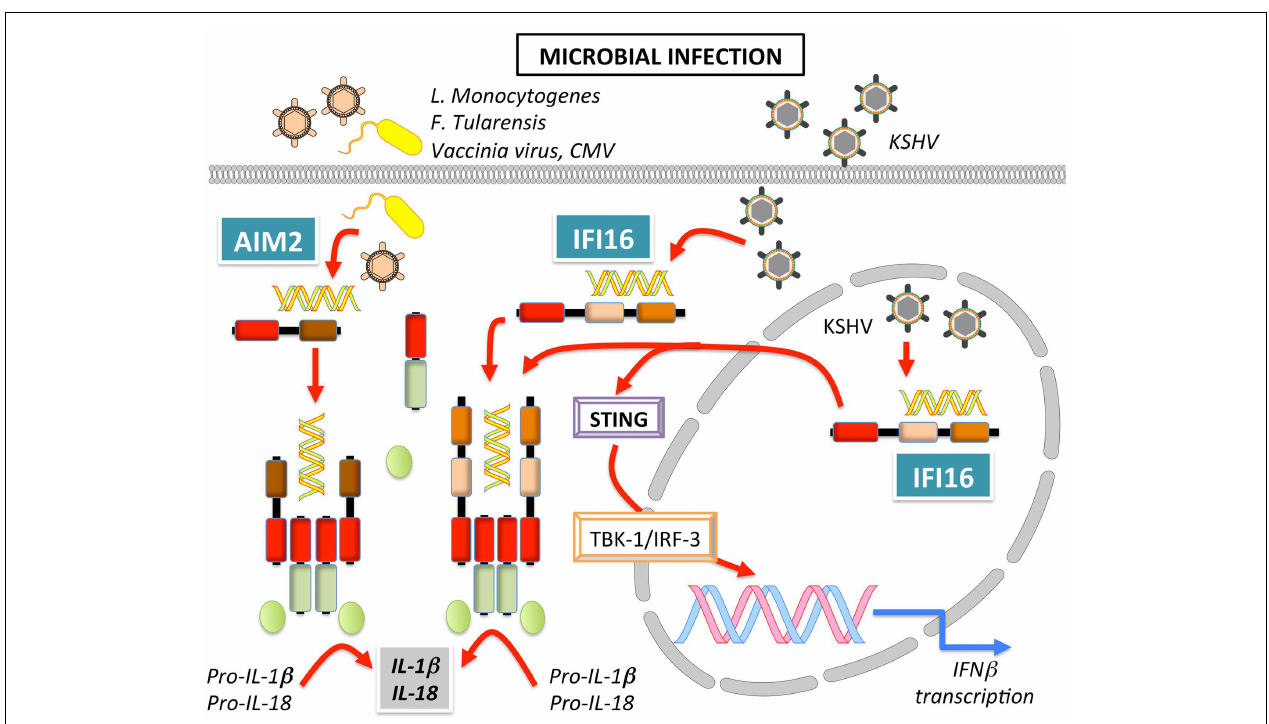
FIGURE 7 | Signaling ofAIM2 and IFI16 leading to inflammasome activation and induction of IFN β in response to bacterial and viral infection